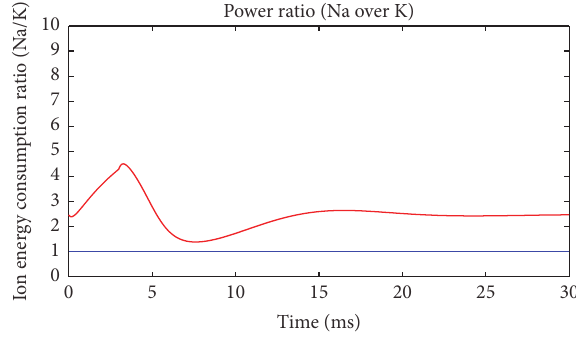
Figure 12: Subthreshold net current.